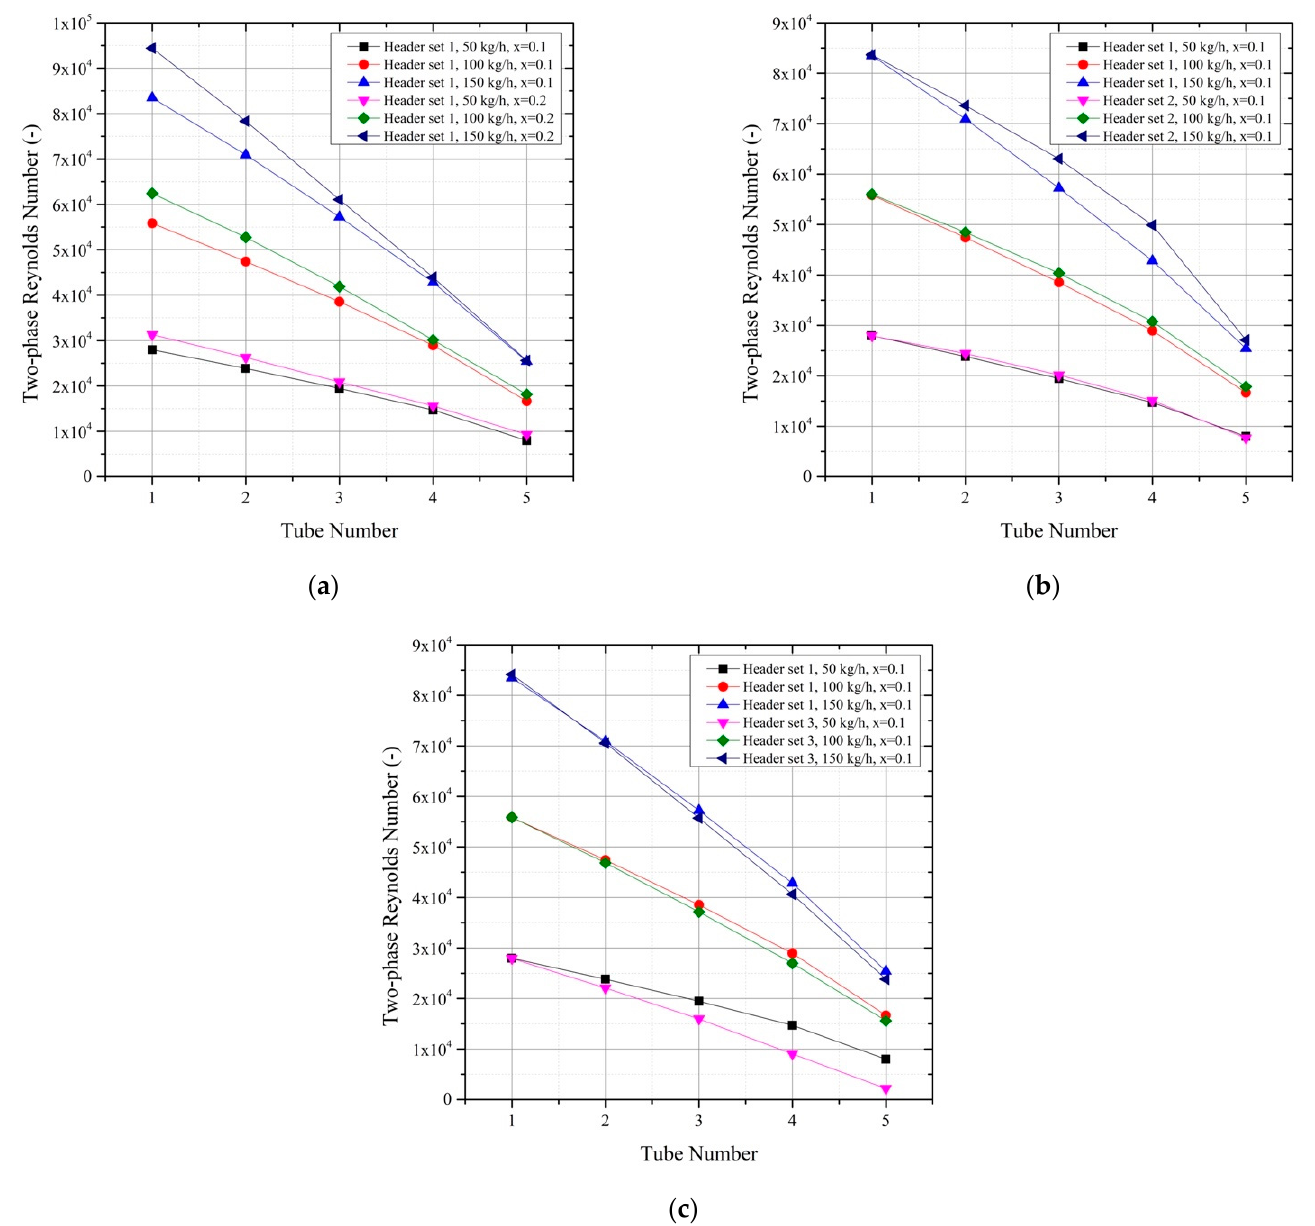
Figure 11. Reynolds number according to the experimental parameters: ( a ) inlet vapor quality variation; ( b ) header outlet diameter variation; ( c ) header height variation.